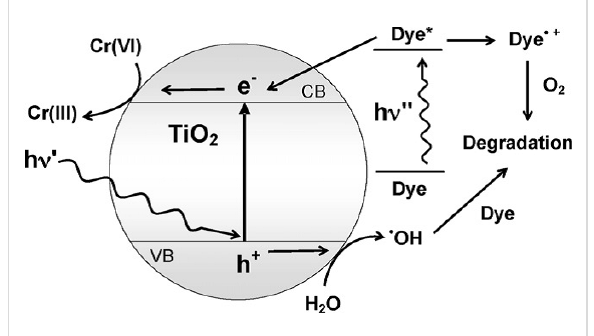
Figure 11: Mechanism for the photocatalytic Cr(VI) reduction by a dye- sensitized TiO 2 nanocatalyst.